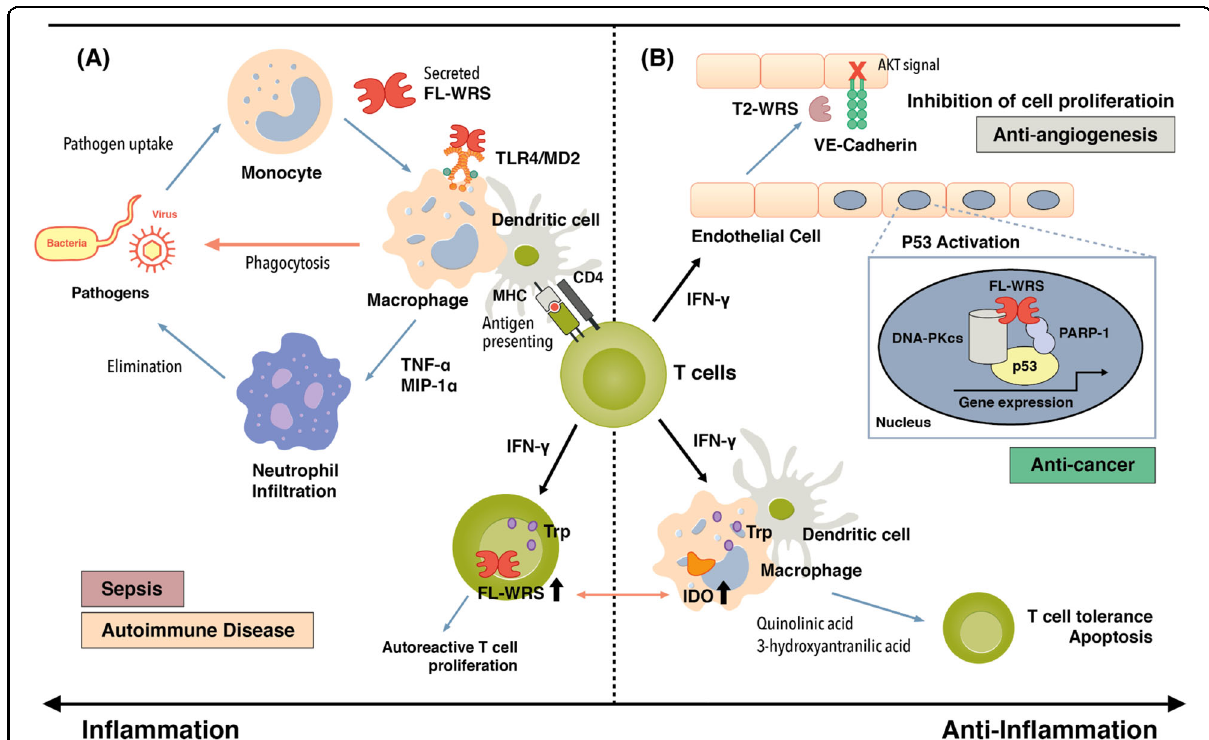
Fig. 3 Roles of WRS in “ Yin-Yang ” immune regulation and its relation to immune diseases. a Upon infection, FL-WRS is rapidly secreted from monocytes to activate macrophages via TLR4/MD2, which induces innate immune responses, including chemokine production, neutrophil in fi ltration, and increased phagocytosis, eventually leading to pathogen elimination. High levels of WRS probably provoke an acute hyper- in fl ammation in sepsis. Antigen presentation to T cells by dendritic cells induces IFN- γ production, leading to the increased expression of WRS. Overexpression of WRS in T cells is able to reserve Trp, which is essential for cell activation and proliferation and may be involved in the development of autoreactive T cells in autoimmune diseases. b IFN- γ stimulation not only increases WRS secretion but also induces the translocation of WRS into the nucleus. Secreted WRS is proteolytically processed to form T2-WRS, which binds to VE-cadherin and inhibits angiogenesis. Nuclear FL-WRS enhances anti-angiogenesis by regulating cell growth through the phosphorylation of p53, further implying a role for WRS as an anti-cancer agent. Furthermore, an imbalanced activation of indoleamine 2,3-dioxygenase (IDO) relative to WRS in antigen-presenting cells (APCs), including macrophages and dendritic cells, induces an immunosuppressive state, inhibiting the proliferation of immune cells, including T cells, and possibly causing these cells to become tolerant or